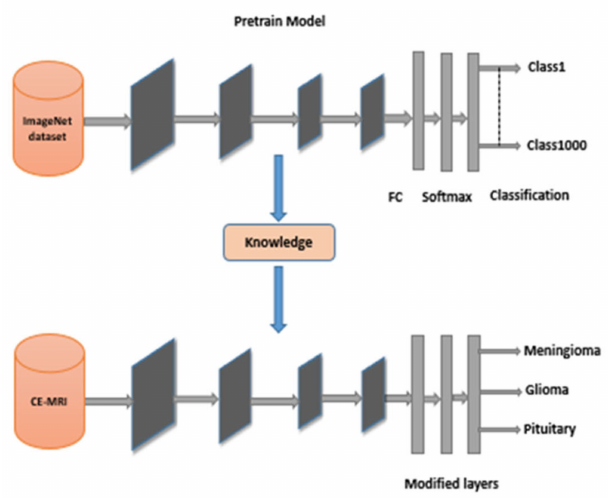
Figure 4. Diagram of transfer learning-based